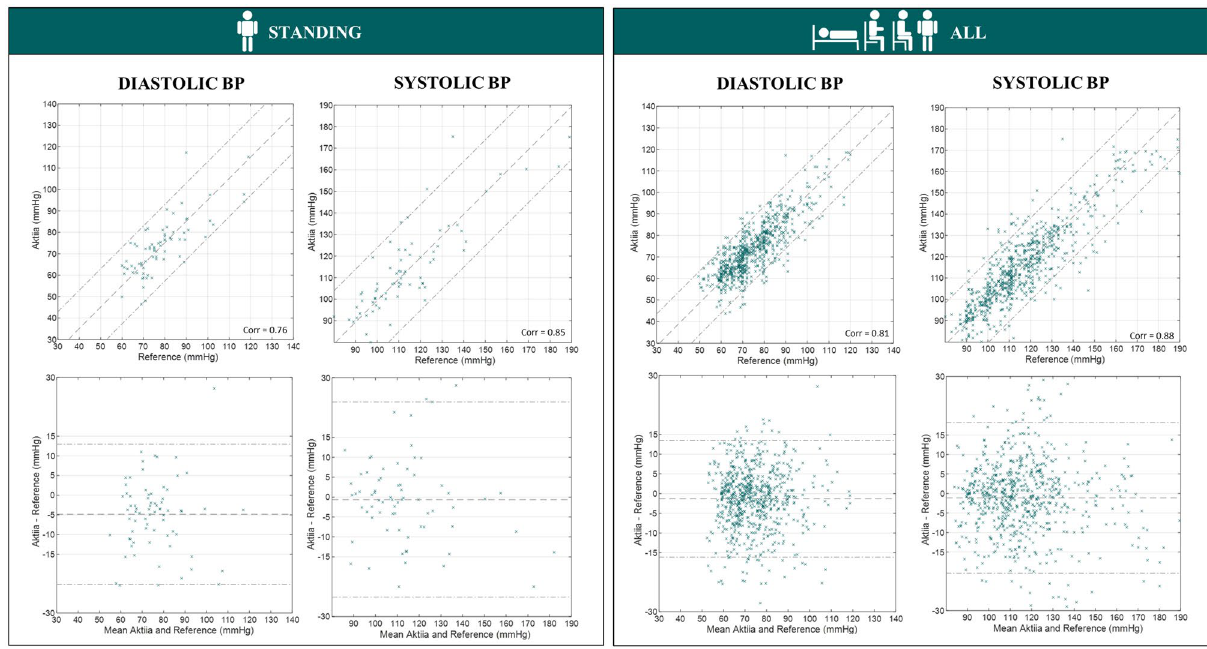
Figure 7. Scatter plots and Bland Altman plots comparing Aktiia BP readings against reference auscultatory readings for standing and all